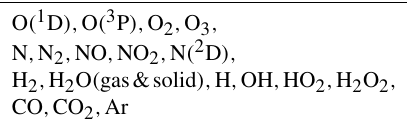
Table 5. List of species used in the Mars model